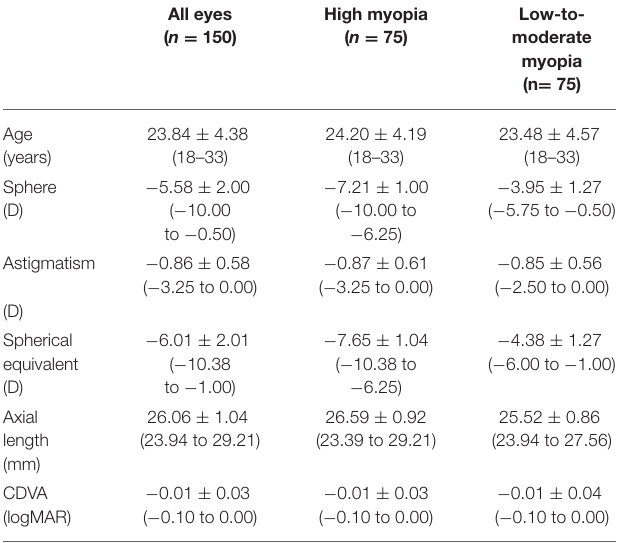
TABLE 1 | Demographic and refractive